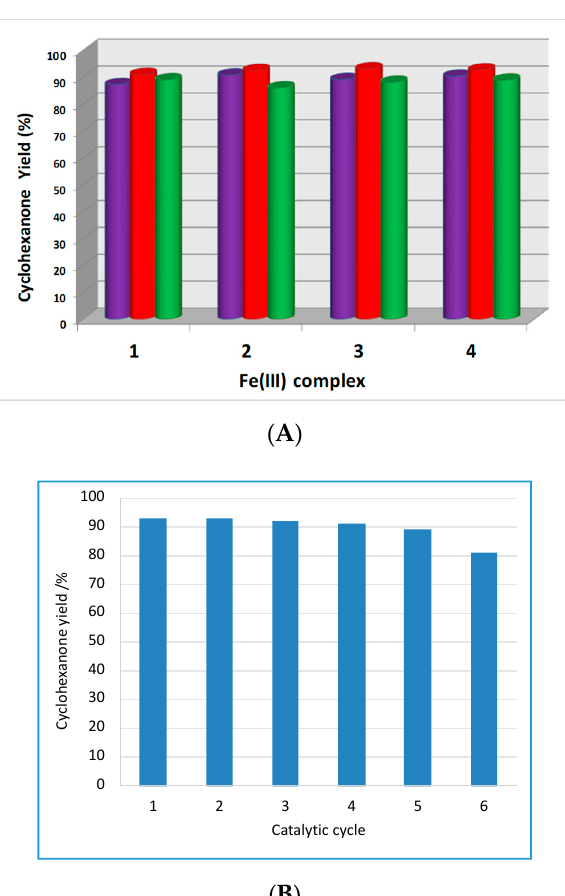
Figure 8. ( A ) Influence of the temperature on the yield of cyclohexanone obtained by MW-assisted oxidation of cyclohexanol with tert -butyl hydroperoxide (TBHP) after 1 h reaction time (purple pillars = reactions performed at 60 °C; red pillars = reactions performed at 70 °C, and green pillars = reactions performed at 80 °C). ( B ) Maximum yield of cyclohexanone obtained in consecutive recycles of the MW-assisted oxidation of cyclohexanol by tert -butylhydroperoxide catalyzed by 3 after 1 h reaction time.